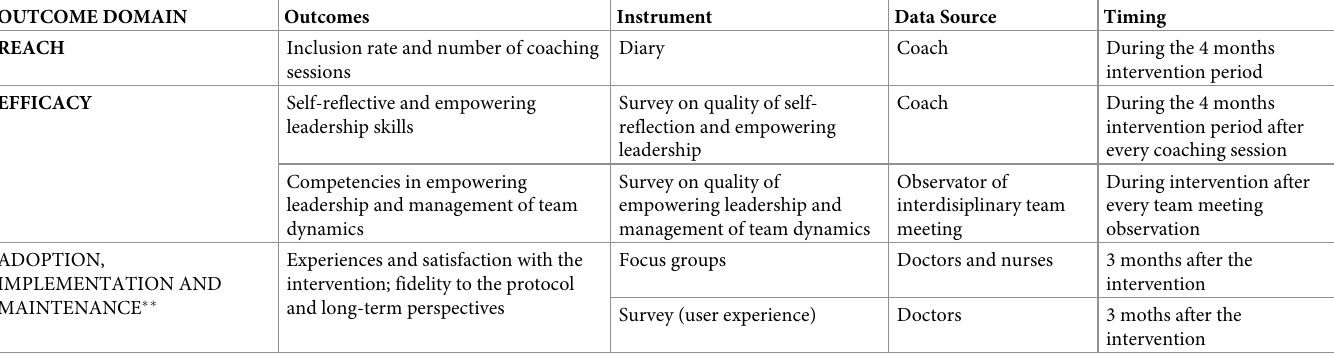
Table 4. Overview of collected data and timelines: Tertiary outcomes � .